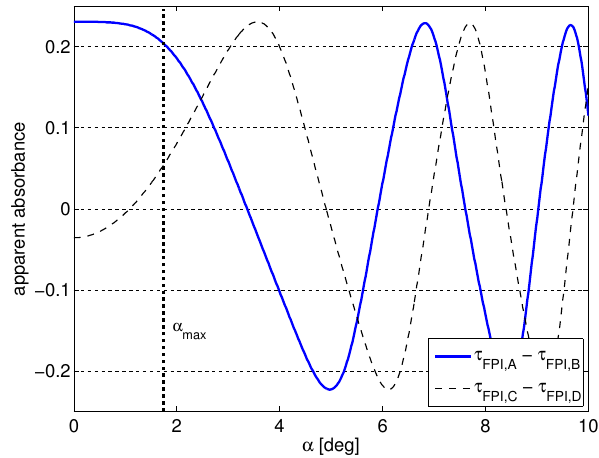
Figure 4. AA FPI as a function of the incident illumination angle α = 10 18 moleccm − 2 (blue for an SO 2 slant column density of S SO 2 drawn line): small changes in cos α cause a shift of T FPI in wave- length, which leads to an oscillating progression of AA FPI over α . α max ≈ 1 . 8 ◦ limits the range of angles for the assumption of parallel incident radiation. The dashed line shows a measurement d AB and with two different FPI surface separations ( d C = d A + 1 2 d D = d A + 3 d AB ). By using more than two FPI settings, the sensi- 2 tivity for arbitrary incidence angles can be obtained (see Sect.